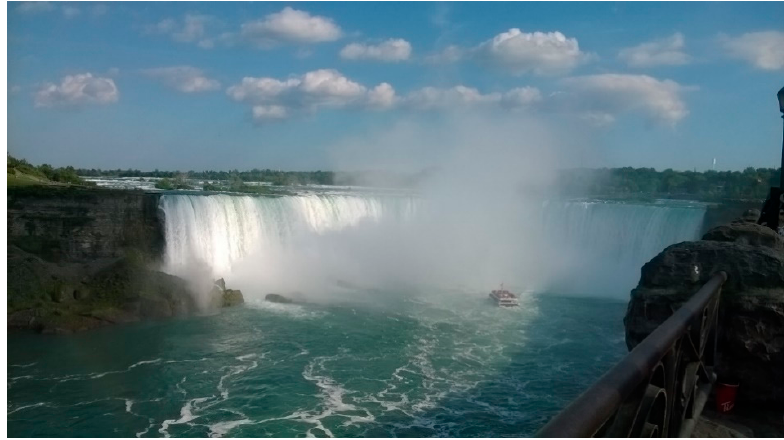
Figure 7. Niagara Falls, Canadian Side. Wikimedia Commons (photo by Cjsinghpup).